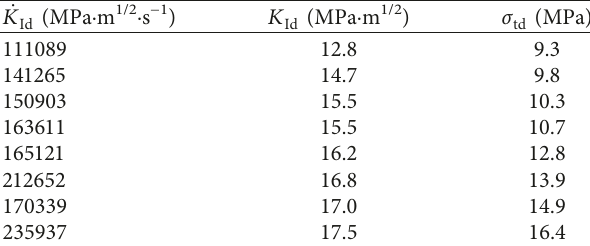
Table 4: Dynamic fracture toughness and dynamic tensile strength